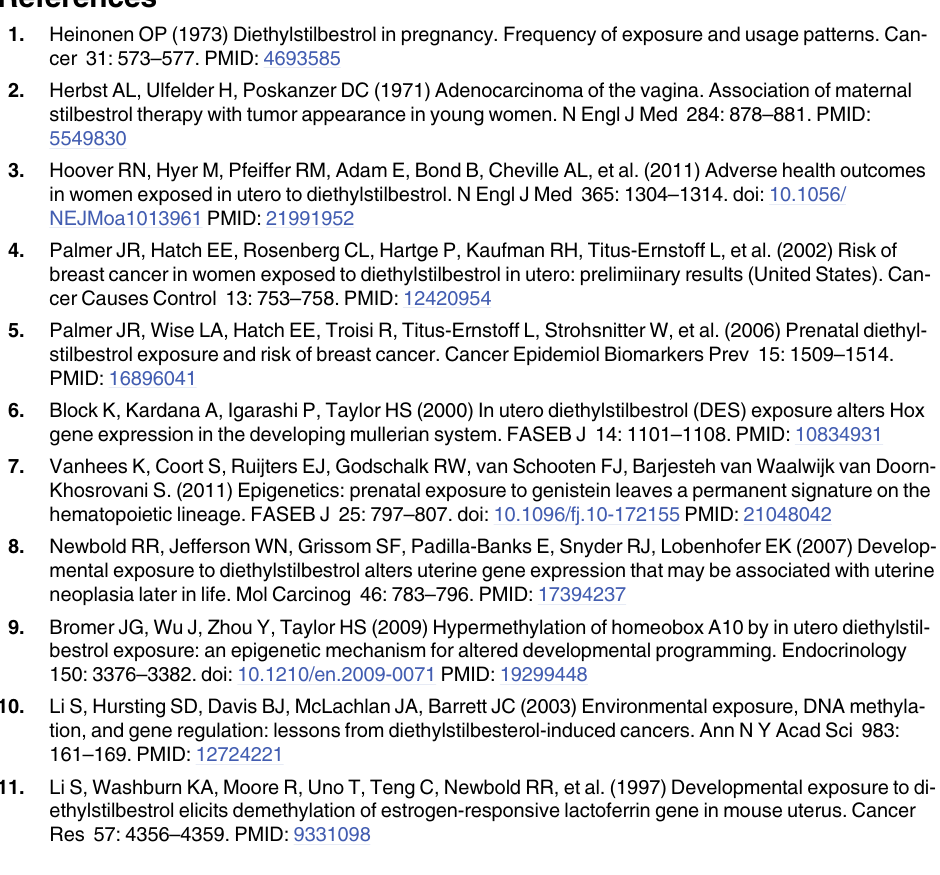
S1 Table. Comparison of mother and daughter reports of in utero DES exposure between participants in the Mother ’ s Validation Study and The Sister Study. S2 Table. Pearson ’ s correlation coefficients between duplicates using methylation beta val- ues for Infinium I and Infinium II probes. S3 Table. CpGs from 9 genes previously implicated to respond to DES exposure in animal